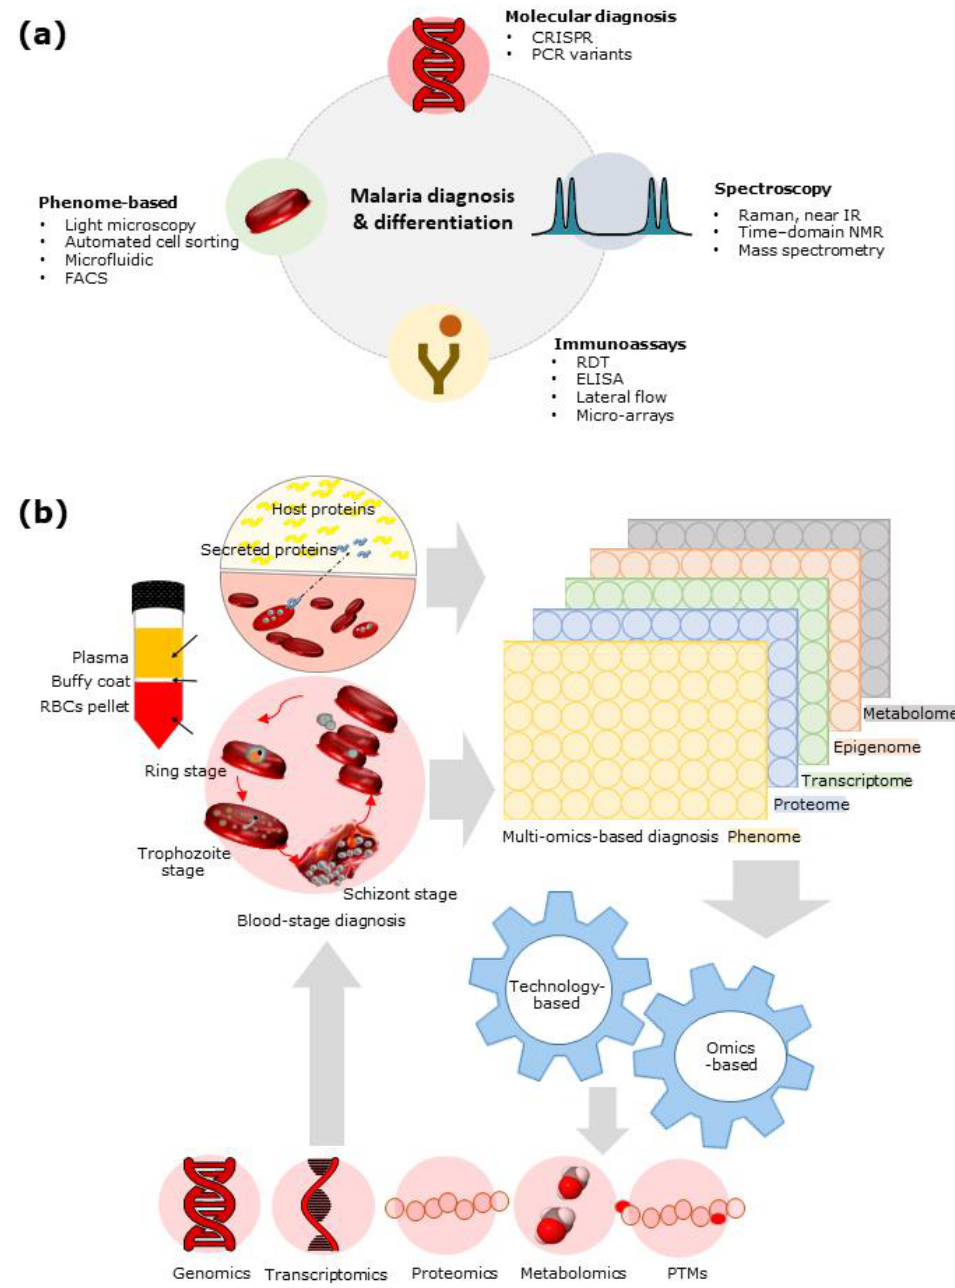
Figure 1. ( a ) Malaria diagnosis and differentiation of Plasmodium spp. in the intra-erythrocyte circle of the host system. ( b ) Schematic representation exhibits the workflow of understanding the “black box” of the biological system using a systemic sample type. The unraveling of the biomolecules and their interactions allows pathways to be decoded using technology and integrated omics-based approaches.